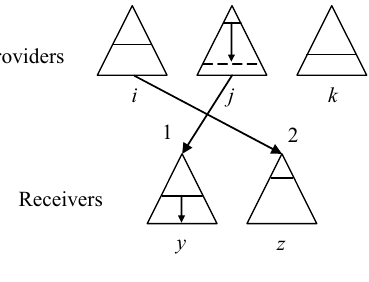
Fig. 5. Example of TBAPR II